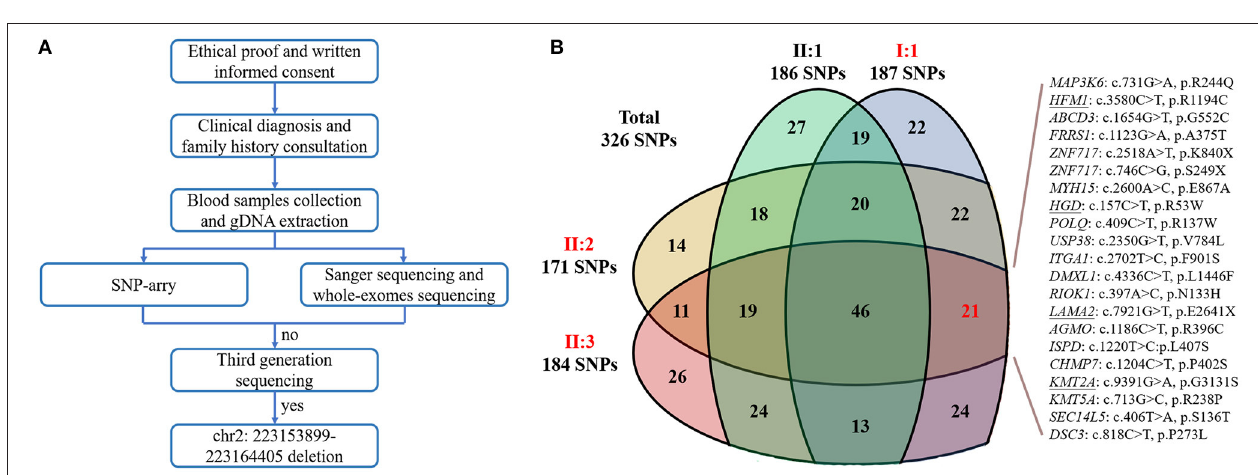
FIGURE 2 | (A) The flow diagram of the present research. “no” indicates that we did not detect the causative gene; “yes” indicates that we identified the genetic defect. (B) The Venn diagram of whole-exome sequencing results. Red words represent the affected members; “SNPs” is an abbreviation of single nucleotide polymorphisms; underlines indicate the variants have been